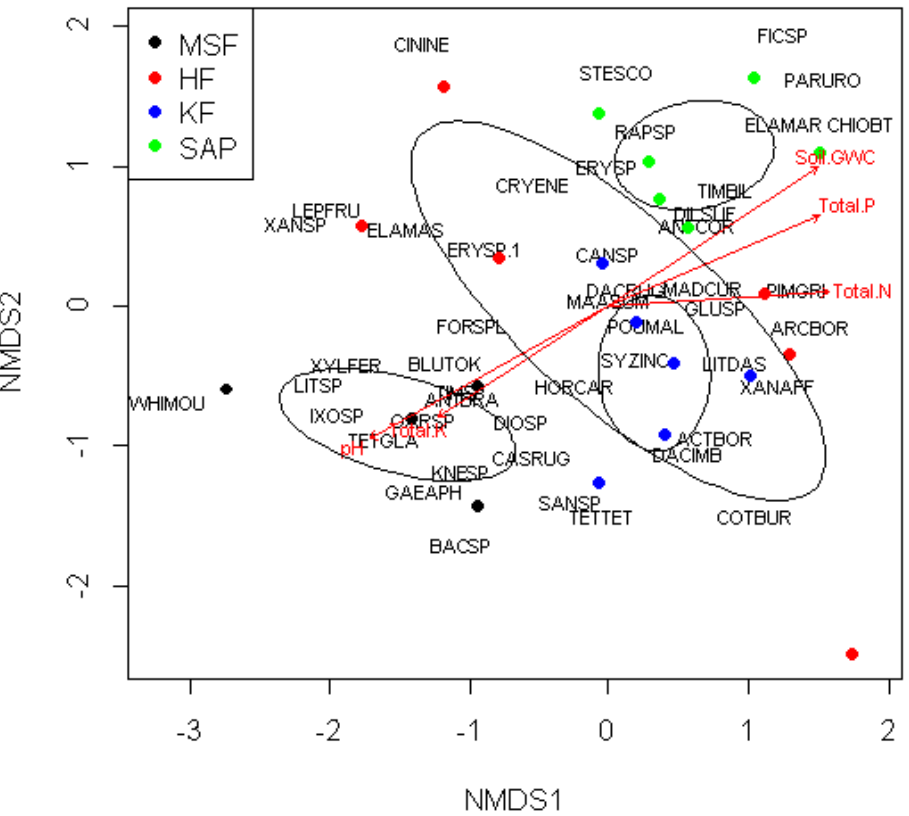
Figure 2. Nonmetric multidimensional scaling (NMDS) ordinations for woody seedlings at the four forest types, using presence-absence data and the Jaccard index, in relation to environmental and soil factors. Different colours denote the four forest types: Mixed peat-swamp forest (MSF, n = 4 plots), heath forest (HF, n = 6 plots), kerapah forest (KF, n = 6 plots) and Shorea albida peat-swamp forest (SAP, n = 6 plots). The direction of the arrow indicates the most rapid change of that variable while the length of the arrow is proportional to the strength of the